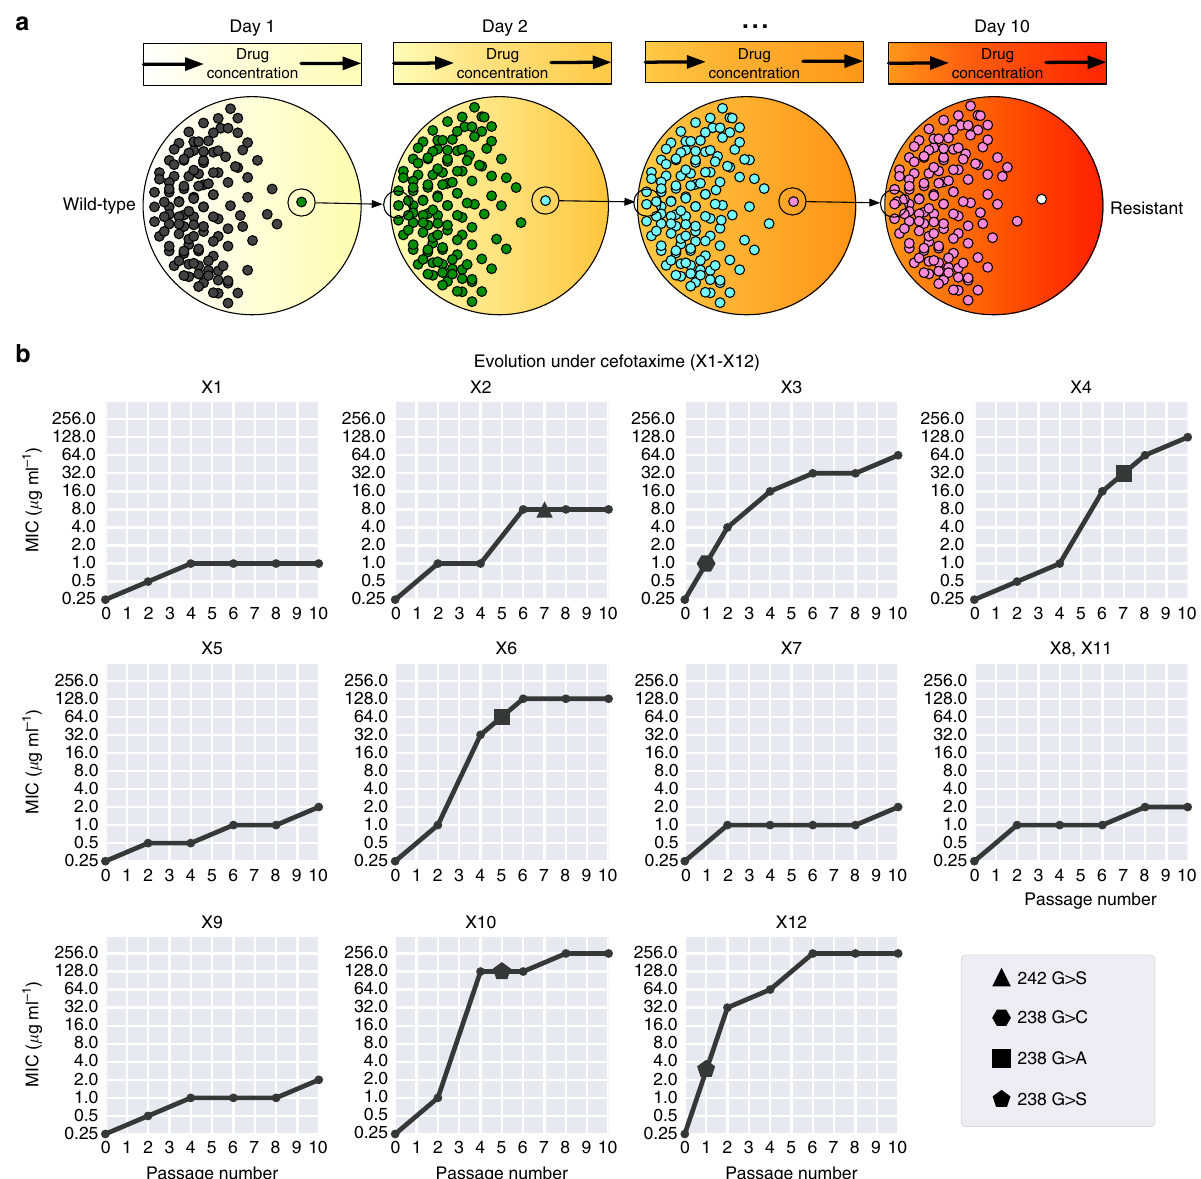
Fig. 3 Experimental evolution reveals divergent collateral response. a A schematic of the evolutionary experiment. E. coli were grown using the gradient plate method and passaged every 24 h for a total of 10 passages. Sixty replicates of experimental evolution were performed. b The MIC for 12 replicates (X1 – X12) under cefotaxime exposure was measured following passages 0, 2, 4, 6, 8 and 10. These values are plotted, revealing heterogeneity in the degree of resistance evolved to cefotaxime. Targeted sequencing of the SHV gene was performed following each passage revealing four different SNVs between the replicates marked by geometric shapes (triangle — G242S, hexagon — G238C, square — G238A and pentagon — G238S). Mutations are marked at the earliest time point they were detected in each Table 1 Antibiotic drugs used in this study Antibiotic Abbreviation Antibiotic group